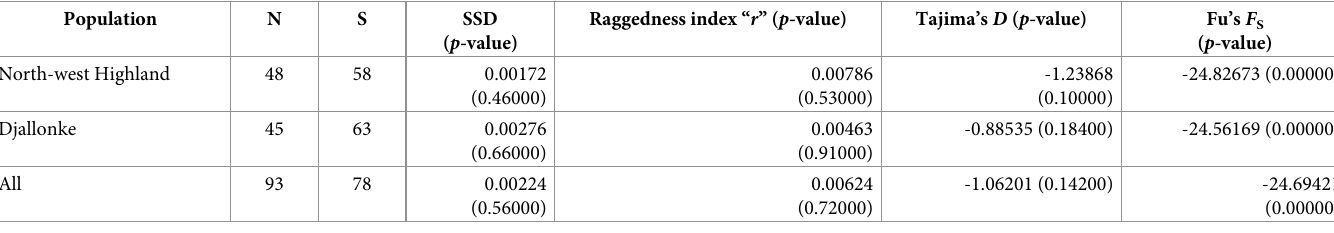
N = sample sizes; S = segregating sites; SSD = sum of squared